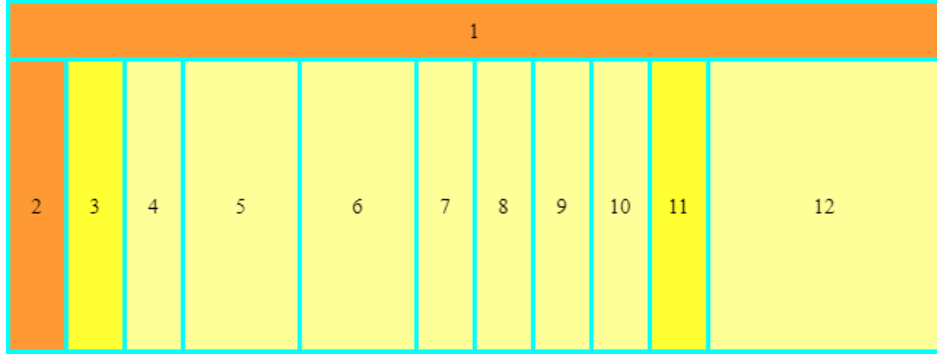
Figure 13. Concept of the given FMEA.